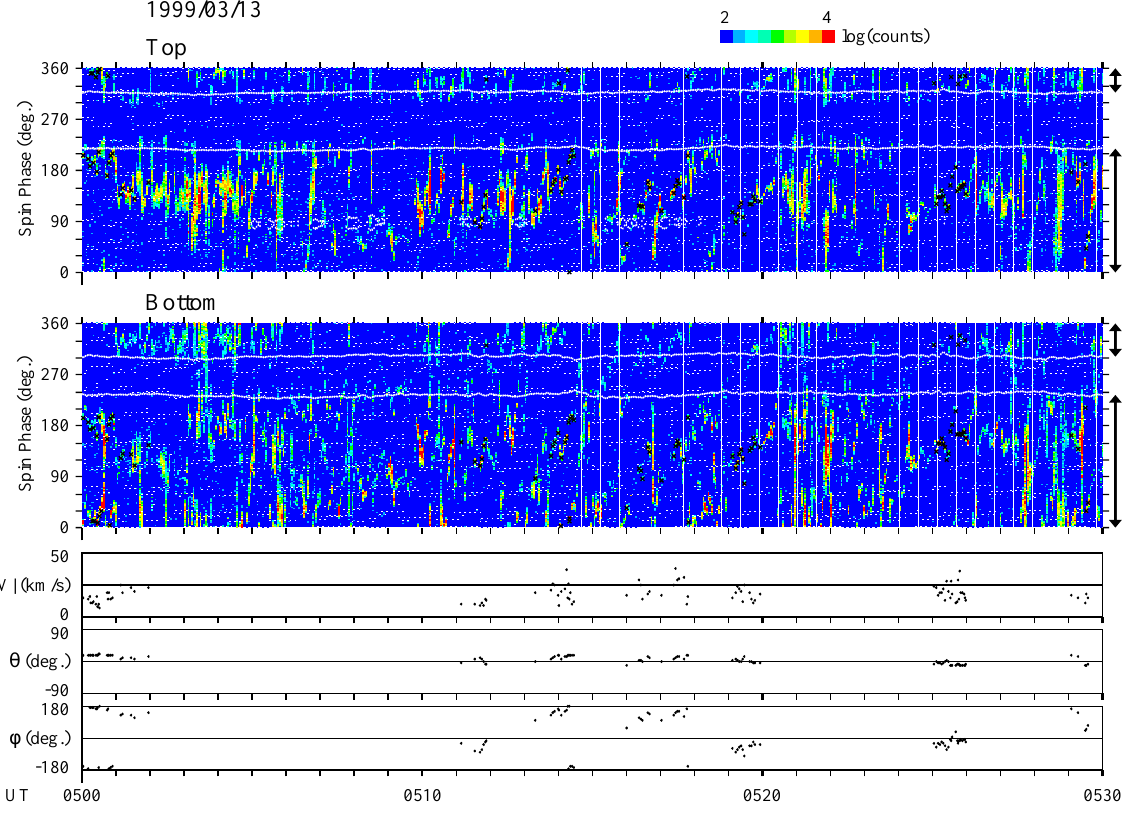
Fig. 3 Fig. 3. Return beams measured by the detectors on 13 March 1999. The quantity of return beams is shown by a color contour for the top and bottom detectors. The data are sorted by time and spin phase. The black marks in the upper two panels show the spin phases which are used to determine convection. Arrows on the right side of each panel show the approximate view angles possible for detecting beams. The white line shows limits of such spin phases. There are two lines during most of the time period, indicating that there is an interval where it is hard to detect return beams for each spin period. However, occasionally, there are four lines, indicating that there are two intervals where it is hard to detect return beams. The bottom three panels show the convection strength | V | , its elevation θ , and azimuthal angles φ